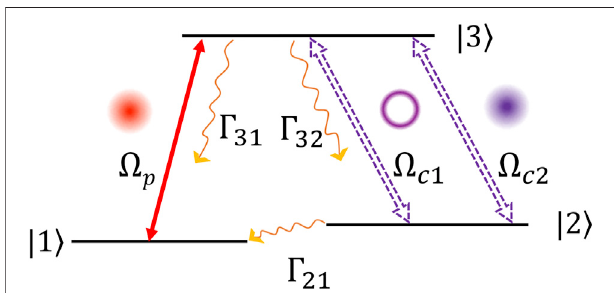
FIGURE 1 | Schematic of a Λ -type three-level system where the probe fi eld Ω 〉 and |3 〉 is a Gaussian beam. The p for the transition of states |1 coupling fi eldbetween|3 〉 and|2 〉 iscomposed byoneLGbeam Ω c 1 and one Gaussian beam Ω c 2 . Γ nm denotes the spontaneous decay rates from | n 〉 to | m 〉